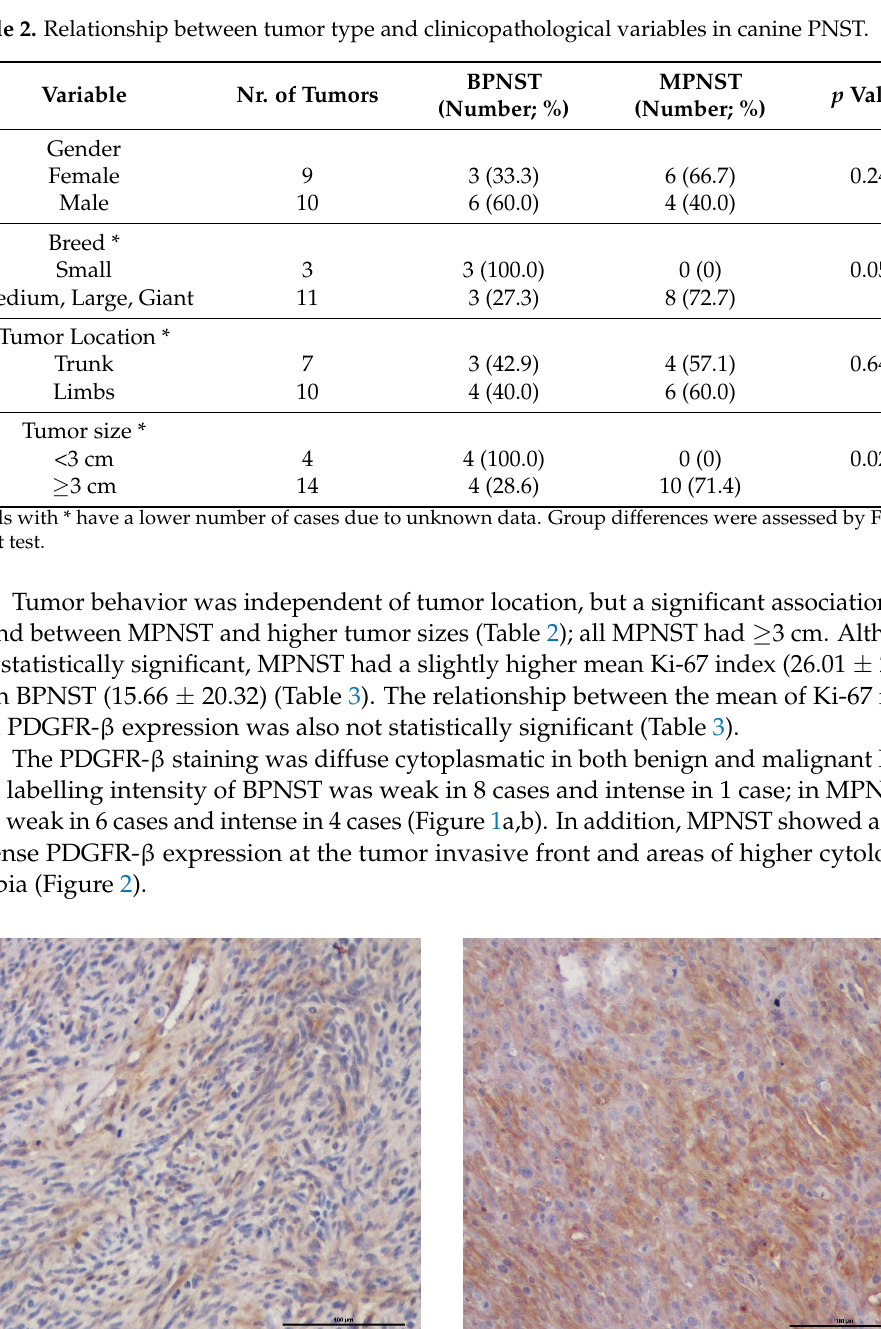
Figure 2. Immunohistochemical staining of PDGFR- β in canine cutaneous MPNST (×100). Tumor invasive front showing high levels of PDGFR- β expression. Table 4. Relationship between PDGFR- β expression and clinicopathological variables in 19 canine PNST. Variable Nr. of Tumors